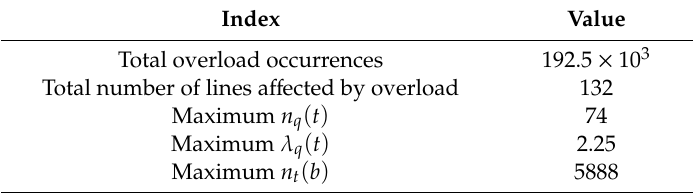
Table 2. Characterization of yearly network performances in the N